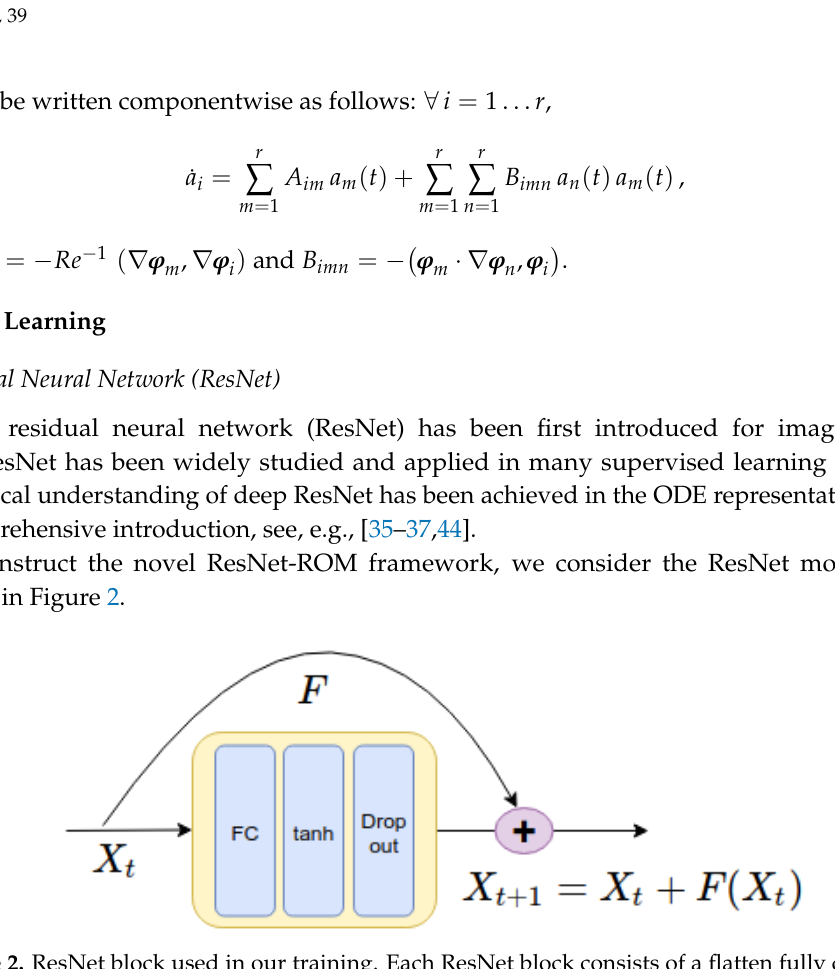
Figure 2. ResNet block used in our training. Each ResNet block consists of a flatten fully connected layer with a tanh activation function, followed by a drop out layer to prevent overfitting. 128 neurons and 5% drop out rate are